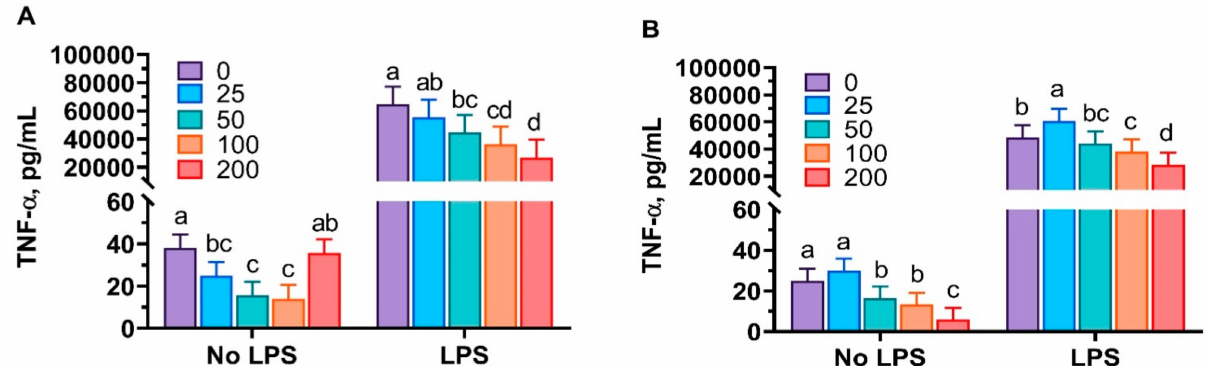
Figure 1. Peppermint oil ( A ) and spearmint oil ( B ) influenced the production of tumor necrosis factor- α (TNF- α ; pictogram per milliliter) from porcine alveolar macrophages (PAMs) in the absence or presence of lipopolysaccharide (LPS). Cells were incubated with various concentrations (0, 25, 50, 100, 200 µ g/mL) of each mint oil in the presence or absence of LPS (1 or 0 µ g/mL) for 24 h. The results were means of values from 6 pigs.